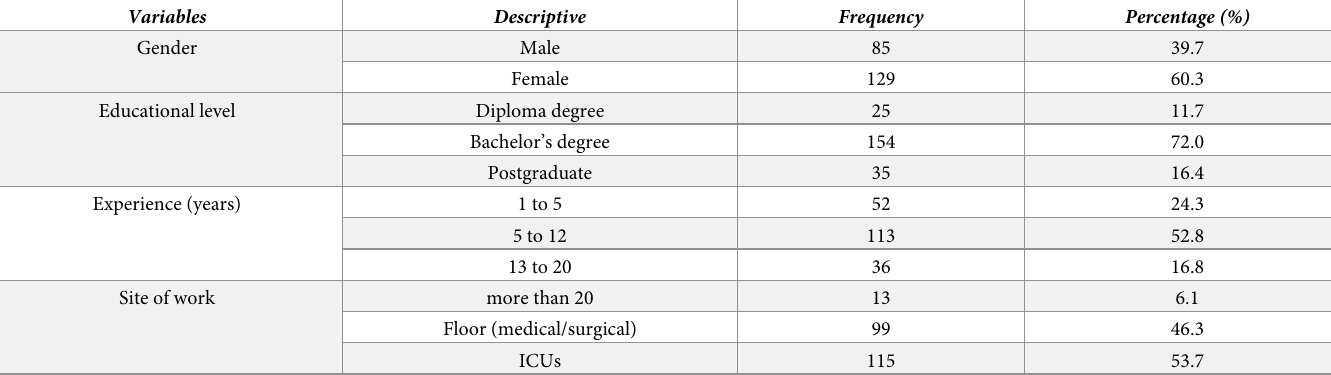
Table 1. Properties of study participants (N = 214). Variables